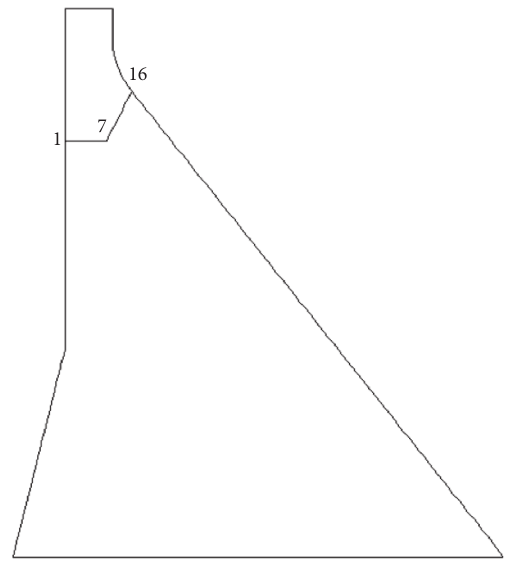
Figure 20: Preset